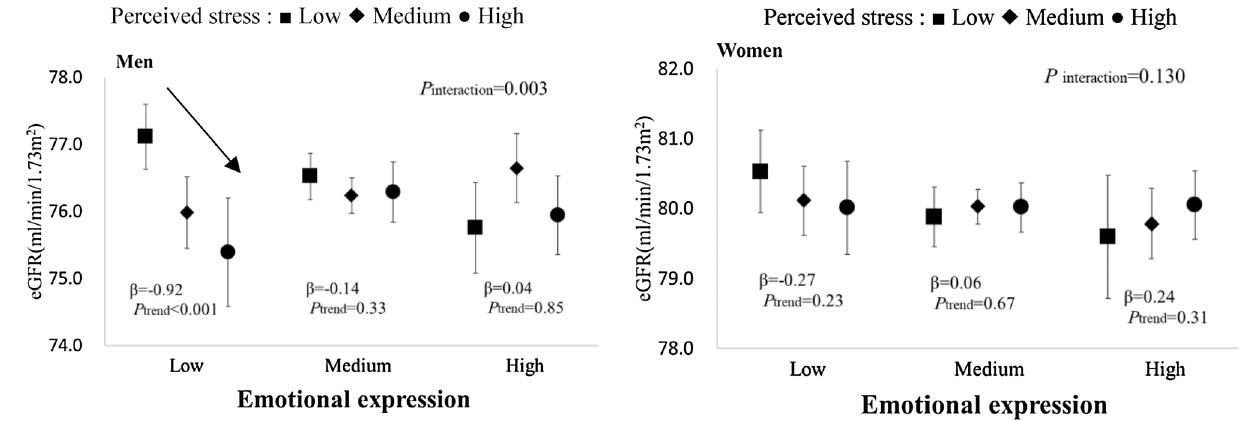
Figure 2. Adjusted mean eGFR values for perceived stress and emotional expression according to gender. Symbols show averages and error bars represent 95% confidence intervals. Adjustments were made for age, area, lifestyle factors (drinking, smoking, physical activity, sleeping hours, energy intake, and body mass index), and psychosocial factors (perceived stress and all coping strategies). β represents the regression coefficient of perceived stress as an ordinal variable and P for trend denotes the statistical significance of